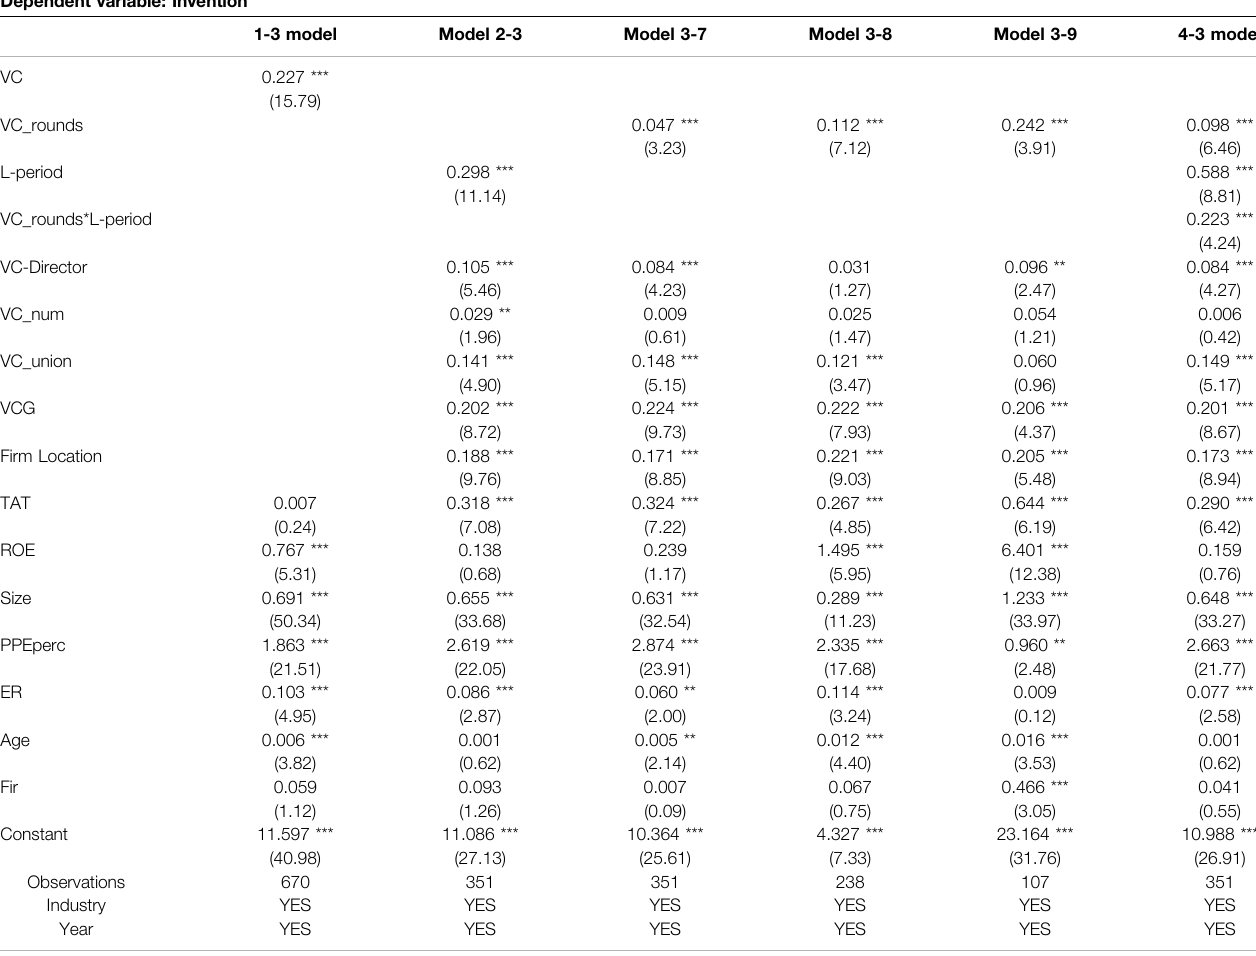
TABLE 7 | Regression results of the replacement innovation capability